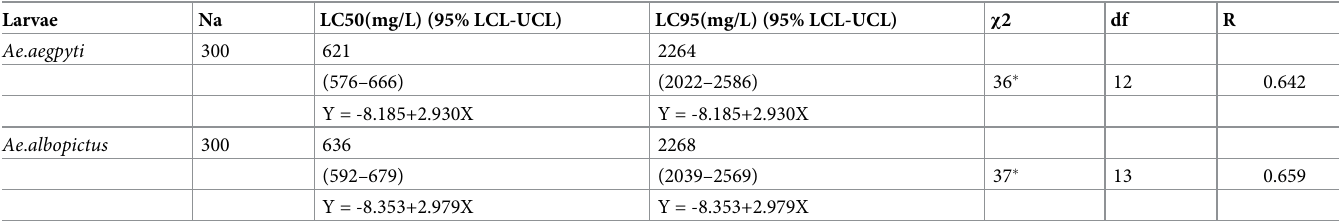
Na: total number of mosquitoes larvae used, n = 25 each with 4 replicates for 3 days; LC 50 : lethal concentration for 50% mortality; LC 95 : lethal concentration for 95% mortality; LCL: lower confidence limits; UCL: upper confidence limits; χ 2: Pearson chi-square; df: degrees of freedom; R: Pearson’s R (note: chi-square values with an asterisk are significant (P <